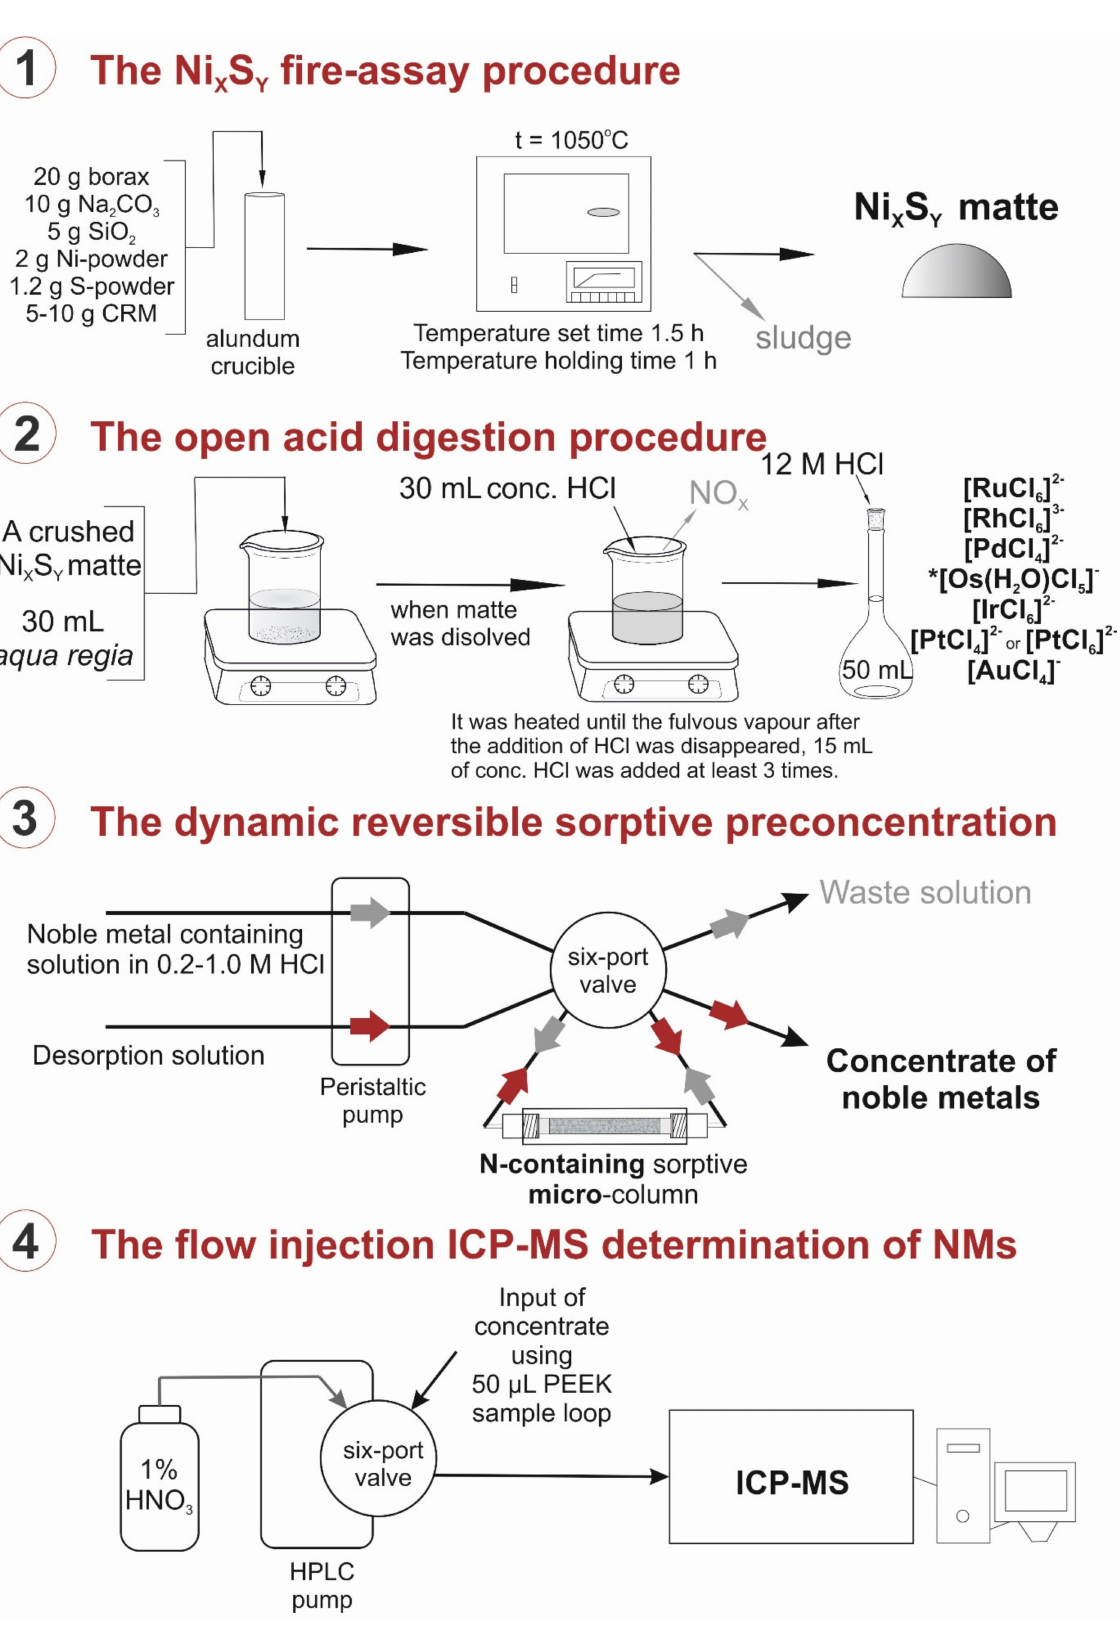
Figure 7. The full scheme of complex procedure of NM determination. * About 30–35% of initial Os was in solution after open acid digestion. Supposedly, Os is present in this complex ionic